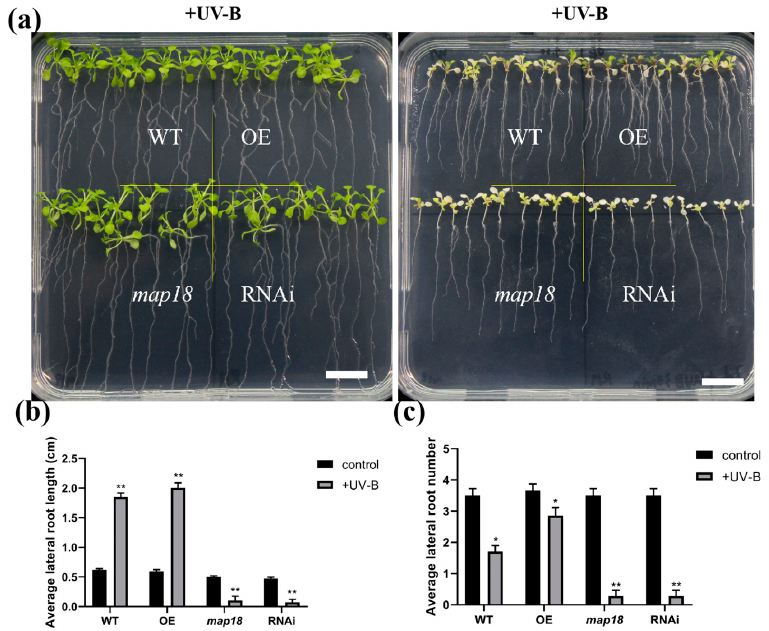
Figure A3. Effects of enhanced UV-B radiation on lateral root growth in A. thaliana . ( a ) The mor- phology of seven-day-old seedlings of wild type, MAP18 overexpression, RNA interference, and map18 mutants before and after UV-B radiation. ( b ) Effect of UV- B on seedling lateral root length. ( c ) Effect of UV-B on seedling lateral root number. Asterisks represent statistically significant groupings in each treated genotype (mixed linear model followed by Student’s t test, * p < 0.05; ** p < 0.01). Scale bars represent 1 cm.